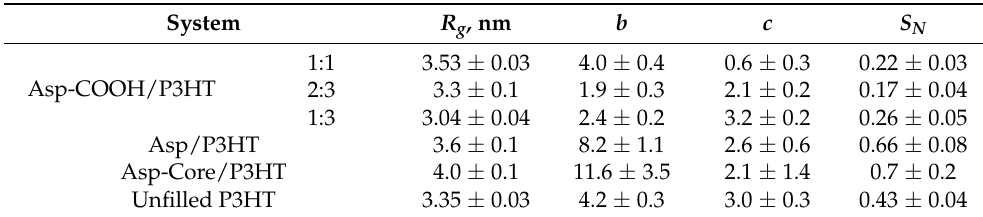
Table 2. Equilibrium values of the radius of gyration R g , asphericity b and acylindricity c parameters, nematic order parameter S N obtained for the P3HT chains in the unfilled sample [24] and in the blends with Asp-COOH at concentrations of 1:1, 2:3 and 1:3.